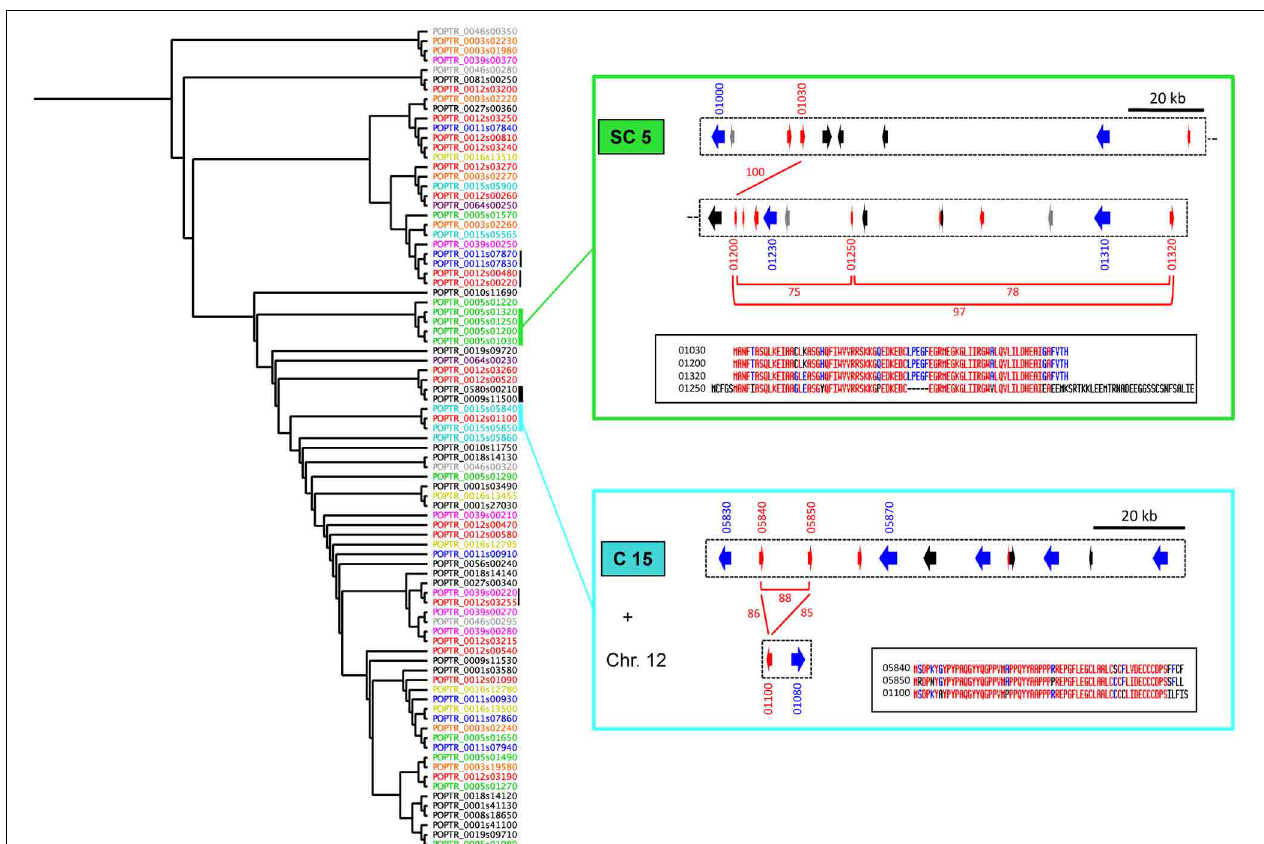
FIGURE 4 | Some families of SPUFs are gathered into the same LRR-RLP clusters. The left-hand part of the figure presents a phylogenetic tree computed from poplar SPUF sequences. Sequence IDs of SPUFs are colored as their clustered LRR-RLPs in Figure 2 . Vertical bars indicate close sequences for which gene models are physically associated within LRR-RLP clusters. Thick bars indicate examples presented in details in Figure 5D (black bar) or on the right-hand part of the figure (green and cyan bars). On the right-hand of the figure, the green rectangle presents a sub-part of